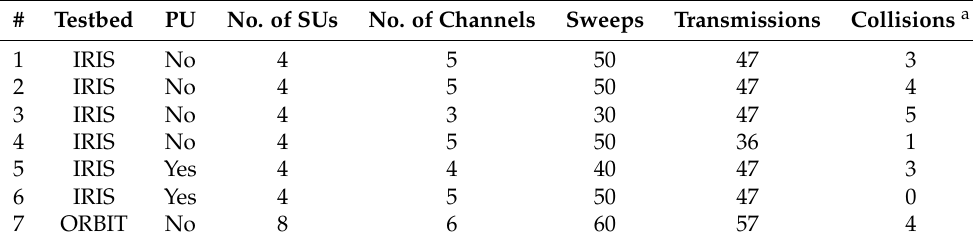
Figure 5. Network Topology: ( a ) 4 secondary users (SUs) full-mesh without primary users (PUs). ( b ) 4 SUs full-mesh with one PU. ( c ) 8 SUs full-mesh without PU. Node IDs correspond to the actual ones employed during the execution of the experiments. Table 1. Experimental